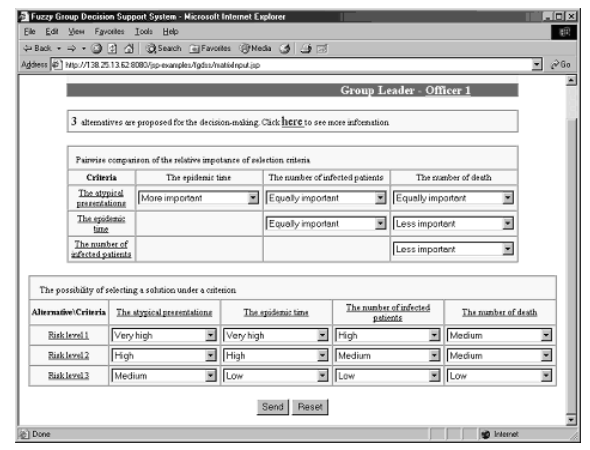
Fig. 5. Criteria comparison matrix and belief level matrix filled by Officer